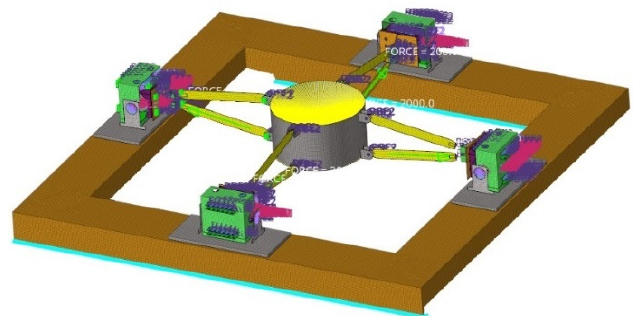
Figure 6. Finite element model of the SMAM.